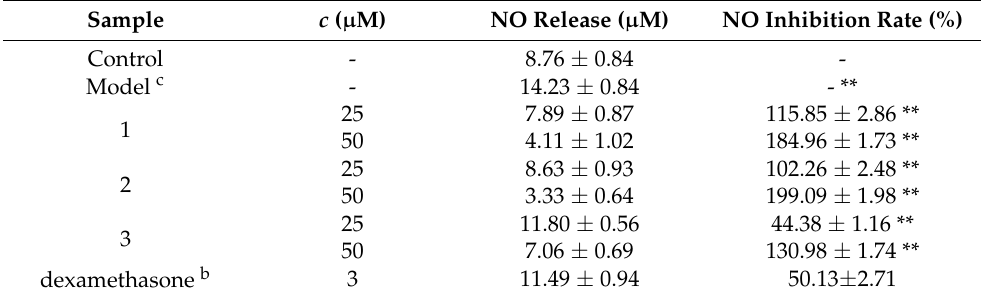
Table 2. Anti-inflammatory effects of compounds 1–3 on LPS-Induced RAW264.7 a . Sample c ( µ M)